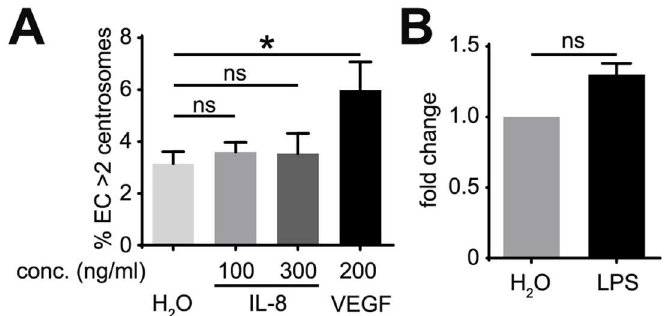
Fig 3. Inflammatory mediators do not induce excesscentrosomes in EC. (A) Frequencyof excess centrosomes in HUVEC after treatment with indicatedfactors for 4 days. (B) HUVEC incubatedwith 10 ng/ml LPS for 4 days prior to determinationof excess centrosomefrequency. Results are shown in fold of increase, and each frequencywas normalizedto its respectivecontrol. Error bars, standarddeviationfrom mean. Statistics: Two-tailedunpairedStudent’s t-test (A), Χ 2 test (B). * , p (cid:20) 0.05; ns, not